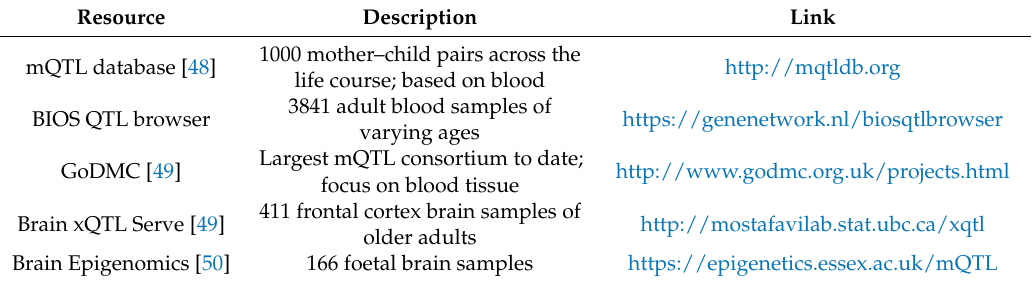
Table 3. Resources that can be used to identify genetic effects on DNA methylation probes. mQTL: methylation quantitative trait locus.